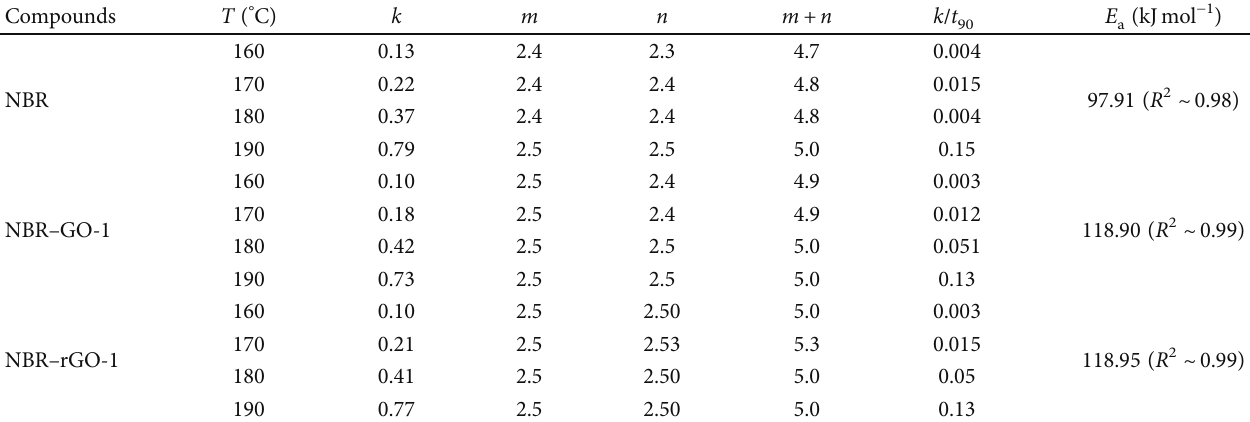
Table 3: Cure kinetic parameters of un-activation sulfur cured NBR, NBR – rGO, and NBR – GO systems.